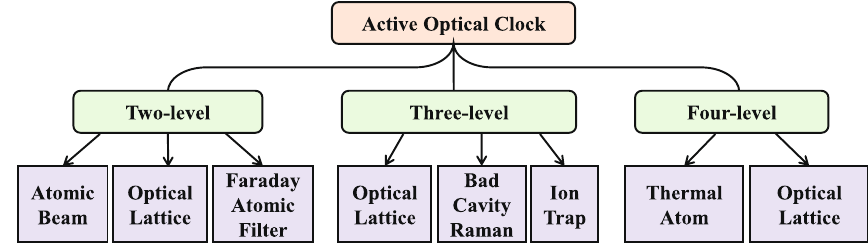
Fig. 3 Different types of AOC based on the transition energy level of quantum gain medium